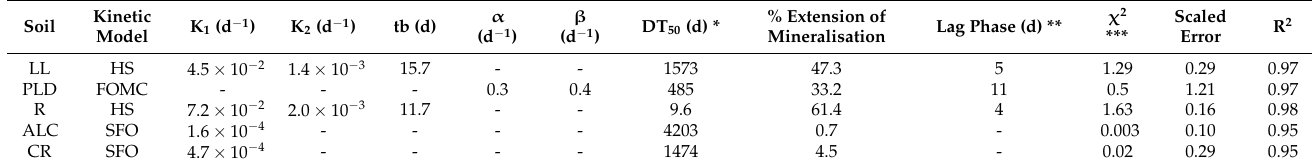
Table 2. Kinetic parameters calculated from chlorpyrifos mineralisation curves obtained under natural attenuation conditions for the studied